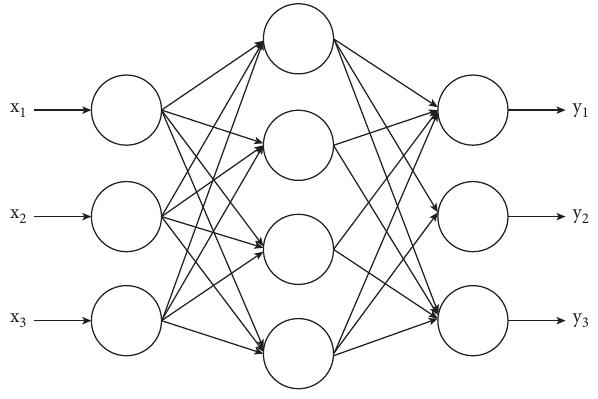
Figure 3: RBF neural network